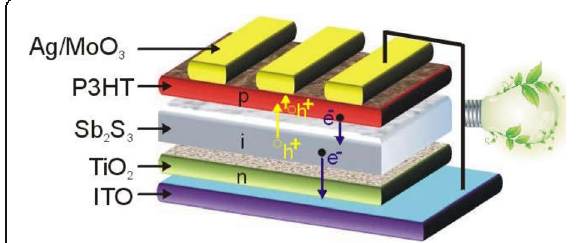
Fig. 1 Illustration of TiO 2 /Sb 2 S 3 /P3HT n-i-p solar cell architecture.h + denotes the hole and e − denotes the